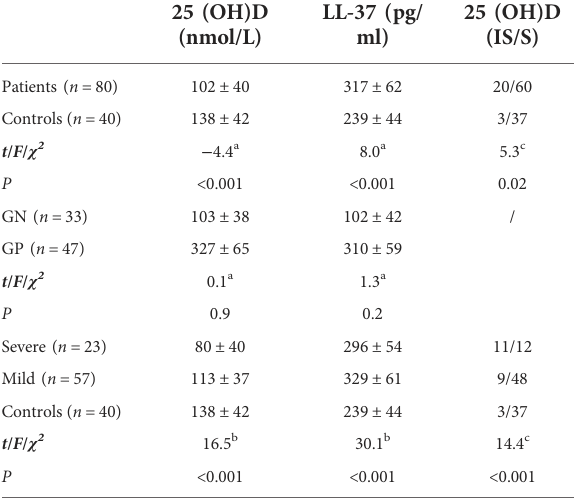
TABLE 1 Comparison of 25(OH)D and LL-37 levels between groups.